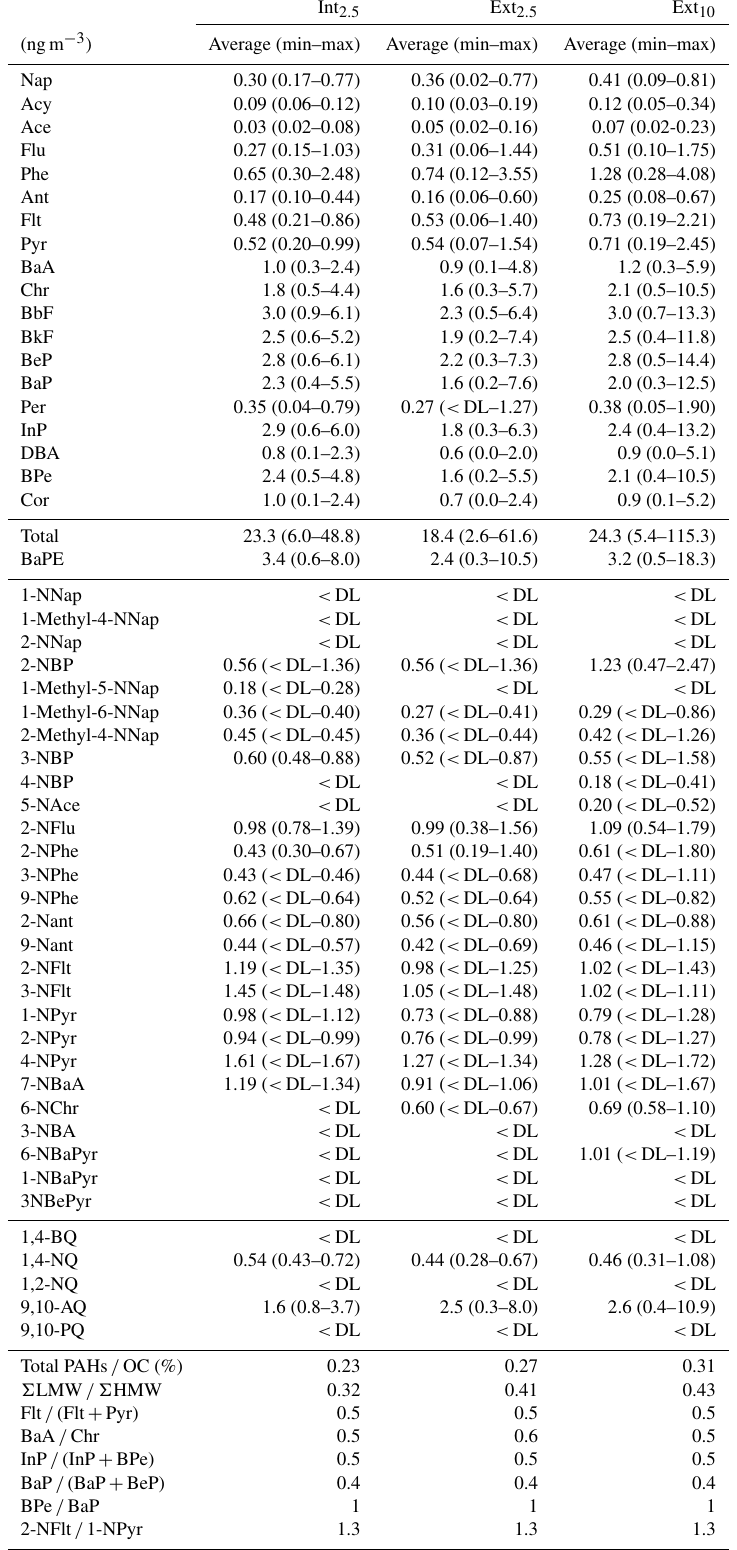
Table 5. Concentrations of PAHs and derivatives for all